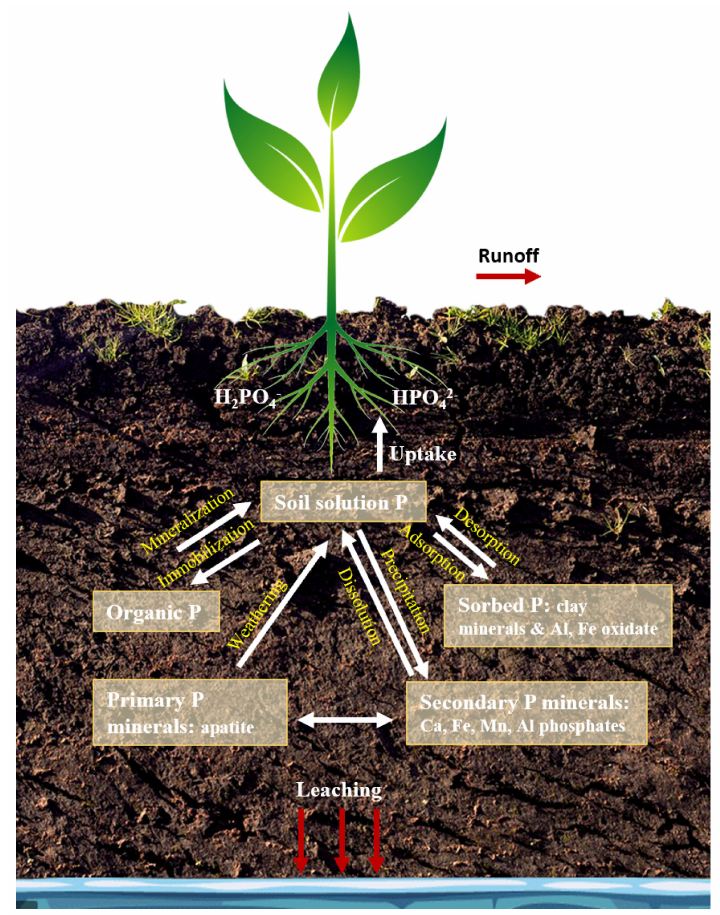
Figure 1. P cycle in